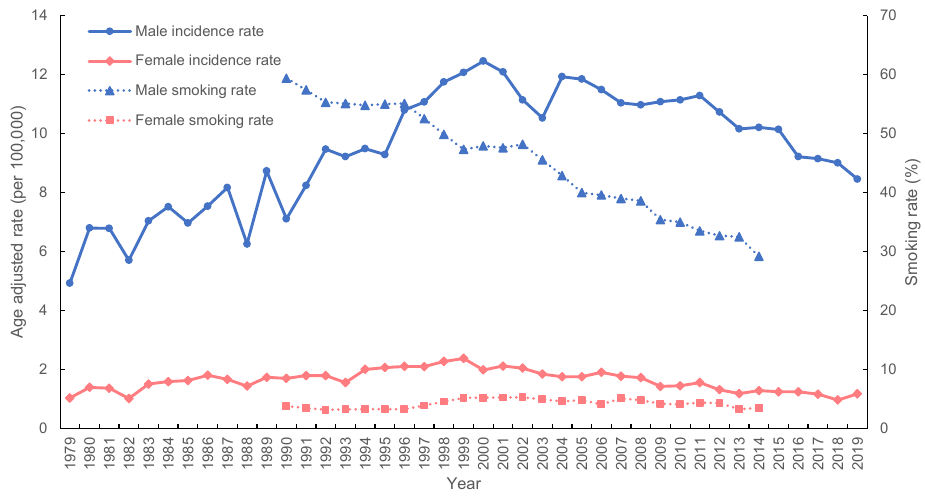
Figure 5. The squamous cell lung carcinoma (SQC) incidence rates between 1979 and 2019, and the smoking rate between 1990 and 2014 in Taiwan.